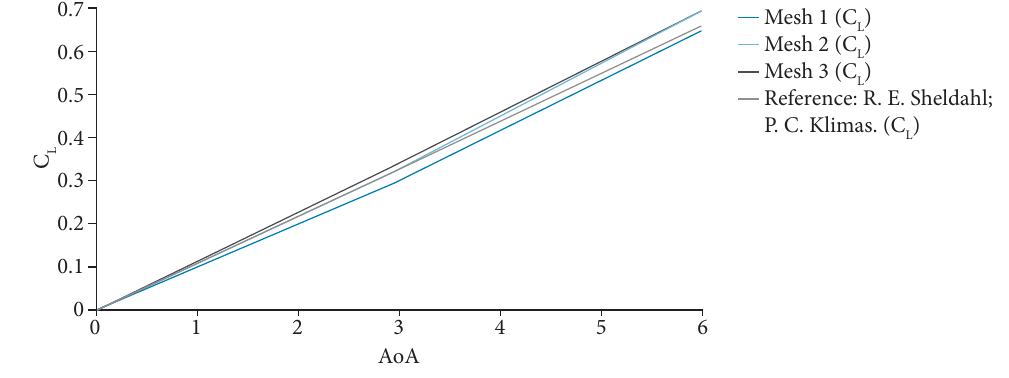
Figure 4. Lift coefficient (C ) as a function of the angle of attack comparing L numerical result with the experimental data in wind tunnel.